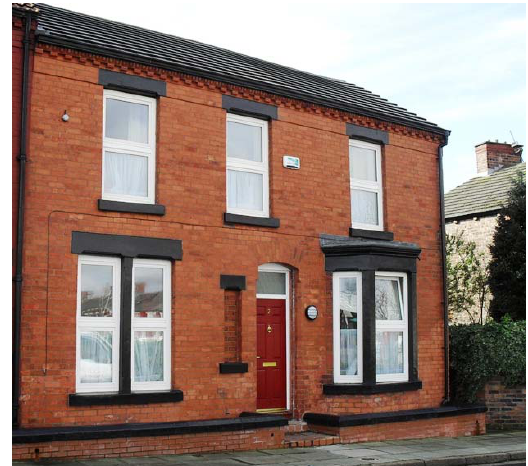
Figure 2. Terraced house after